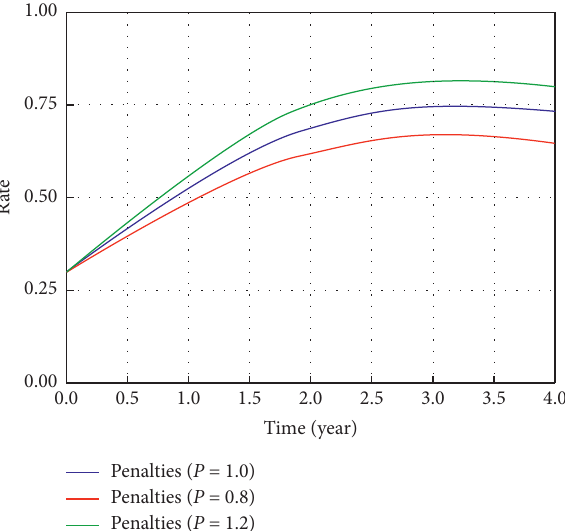
Figure 6: Sensitivity analysis on penalties for adopting prefabricated construction.